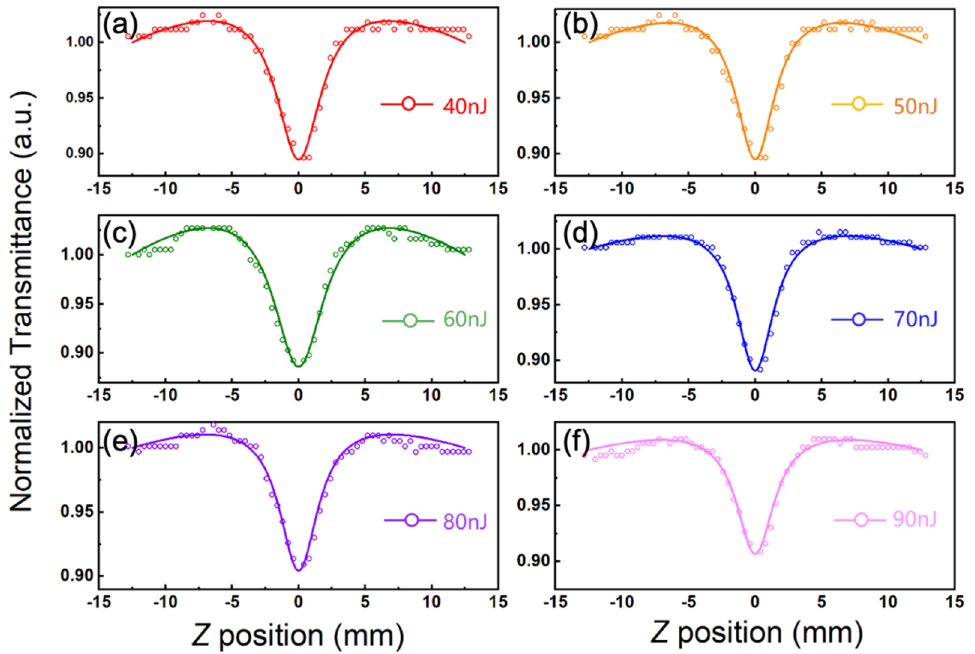
Figure 5. ( a – f ) The nonlinear optical properties of nano-composite samples measured by an open-aperture Z-scan system, with incident laser energy from 40 to 90 nJ.